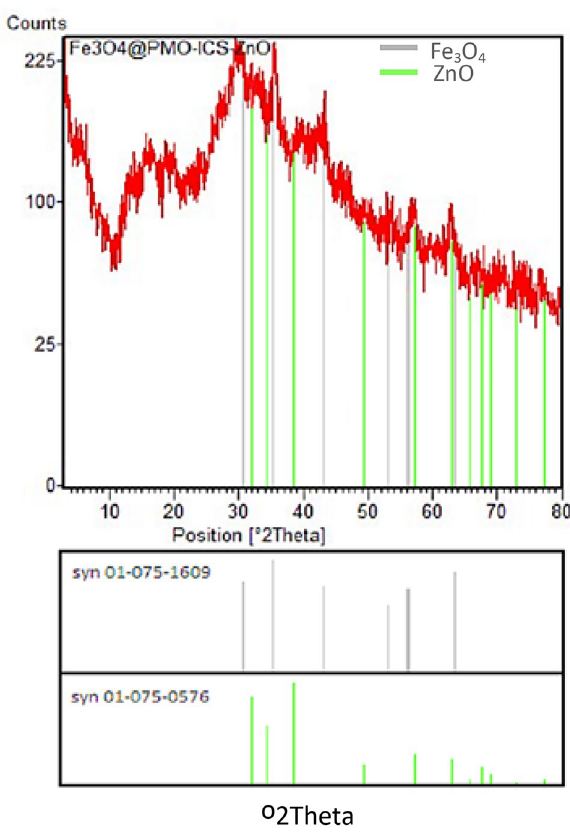
Figure 5. X-ray powder diffraction (XRD) pattern for the Fe 3 O 4 @PMO-ICS-ZnO nanoporous catalyst ( 1 ).